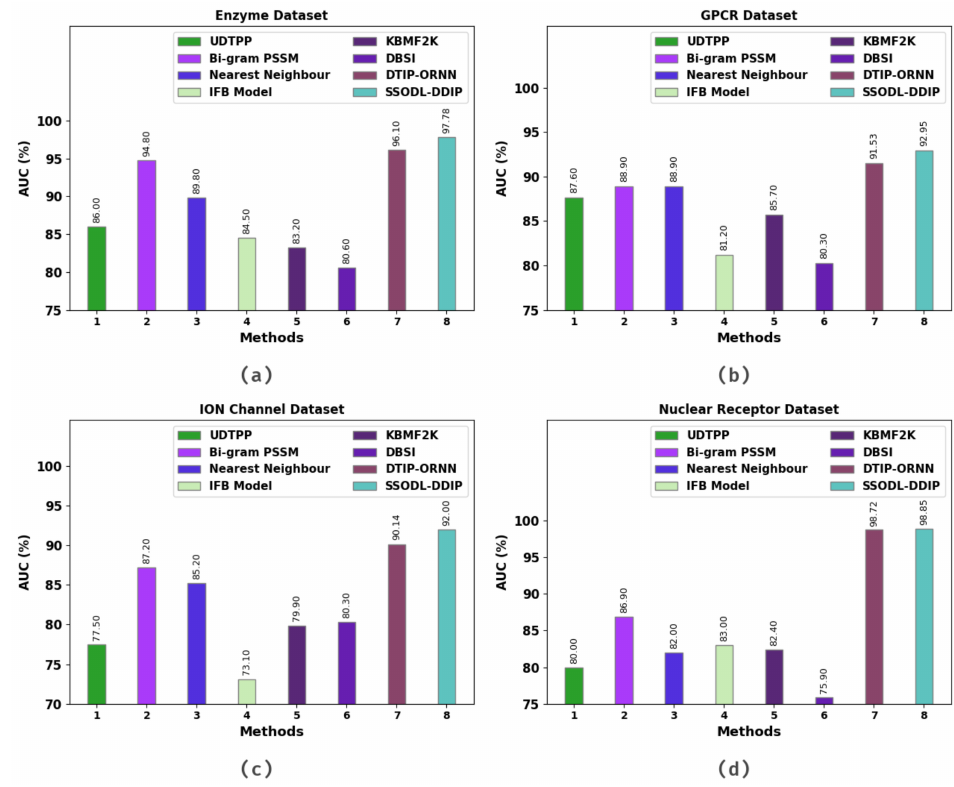
Figure 7. AUC analysis of the SSODL-DDIP technique: ( a ) Enzyme; ( b ) GPCR; ( c ) ion channel; ( d ) nuclear receptor.